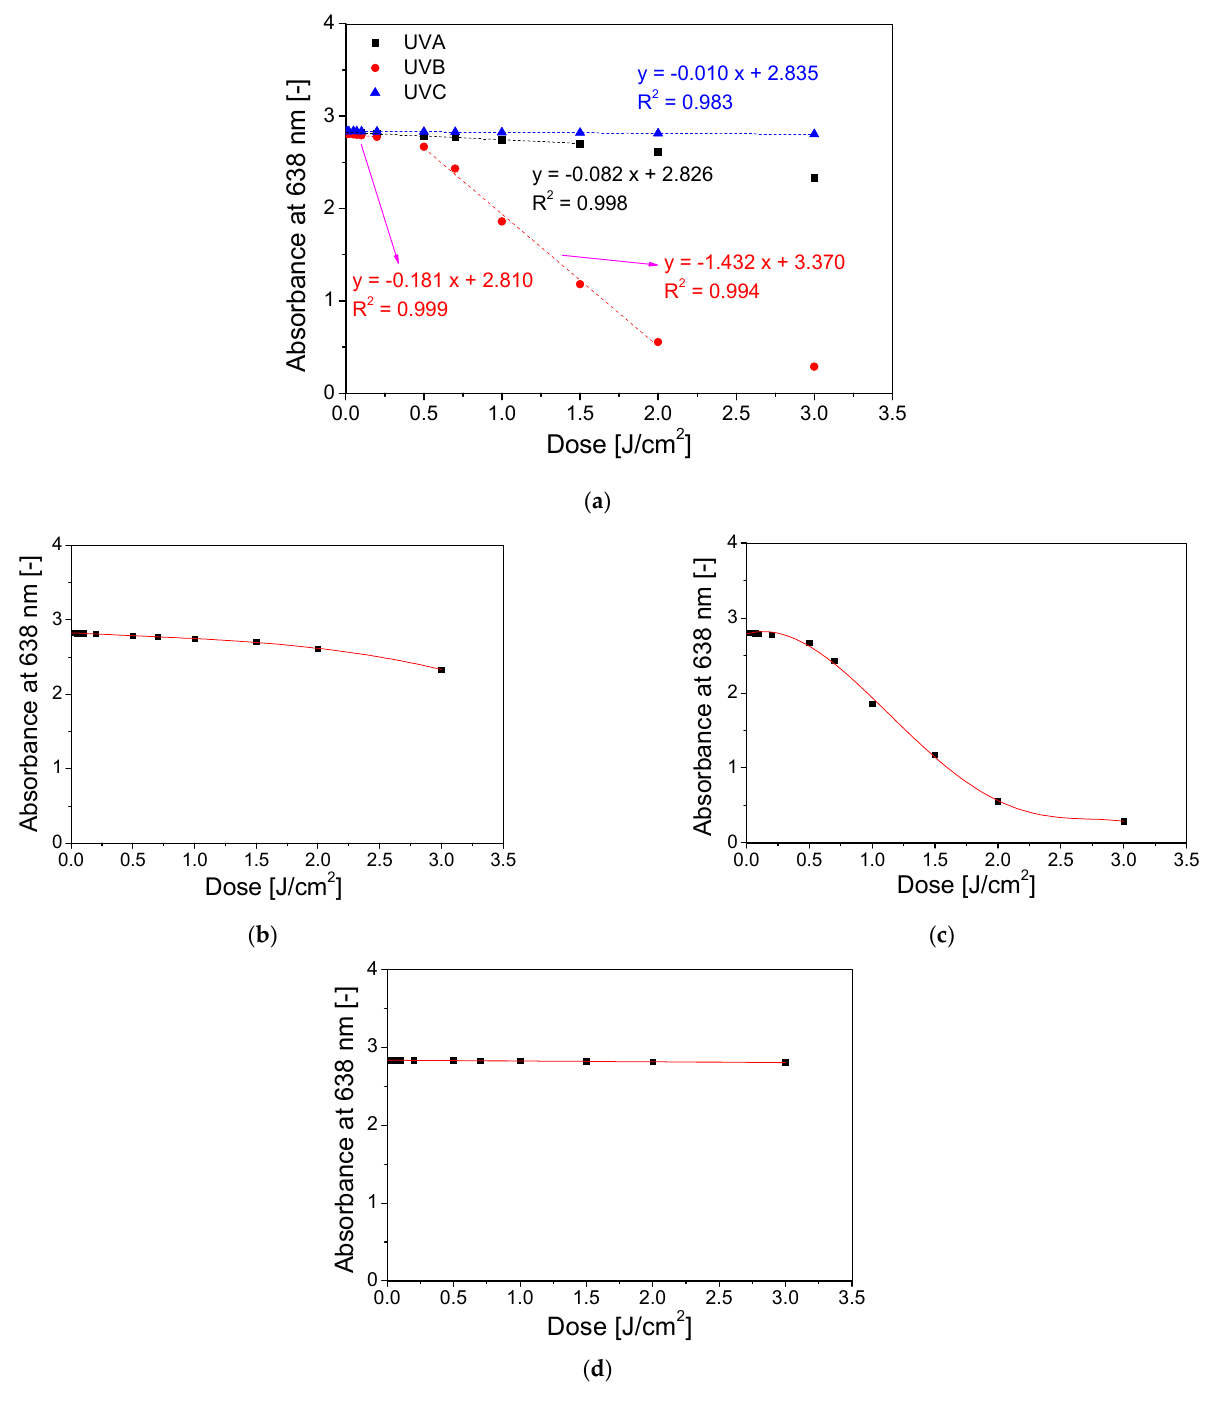
Figure 4. The dose–responses of TBO–Pluronic F–127 gels (60 µ M TBO, 5% H 2 O 2 , 25% Pluronic F–127) with the determined linear dose ranges for samples irradiated with UVA, UVB and UVC radiation ( a ) and with fitted curves for the dynamic dose ranges of samples irradiated with UVA (polynomial curve, ( b )), UVB (polynomial curve, ( c )) and UVC (linear curve, ( d )) radiation. The dose–response of the TBO ‒ Pluronic F ‒ 127 dosimeter was also assessed for the dose of 0.7 J/cm 2 UVB delivered fractionally and non ‐ fractionally (Figure 5). The